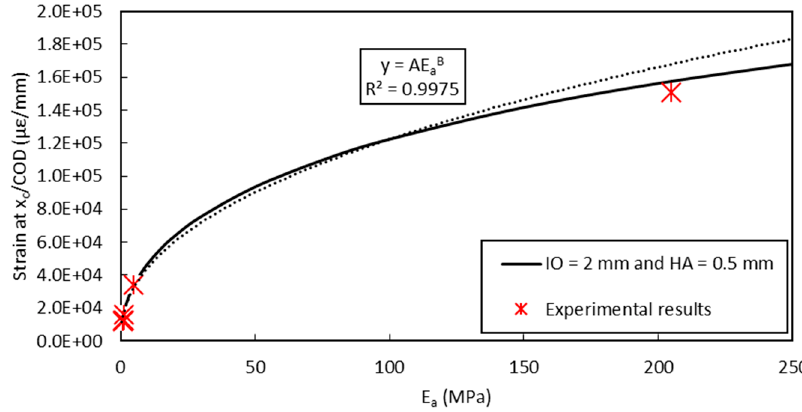
Figure 19. Evolution curve of the shear lag parameter (at x = x c ) versus the elastic modulus of the adhesive E a : FEM simulation (solid line) with exponential regression (dotted line) and experimental results.